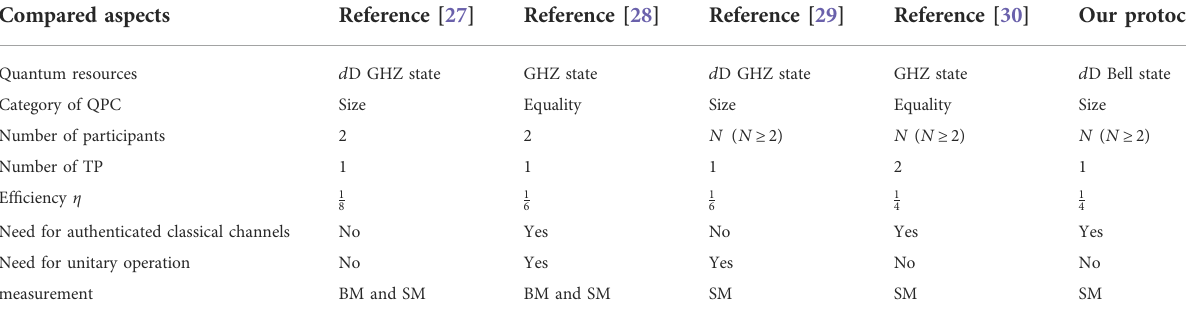
TABLE 2 The comparisons of our QPC with other similar QPC